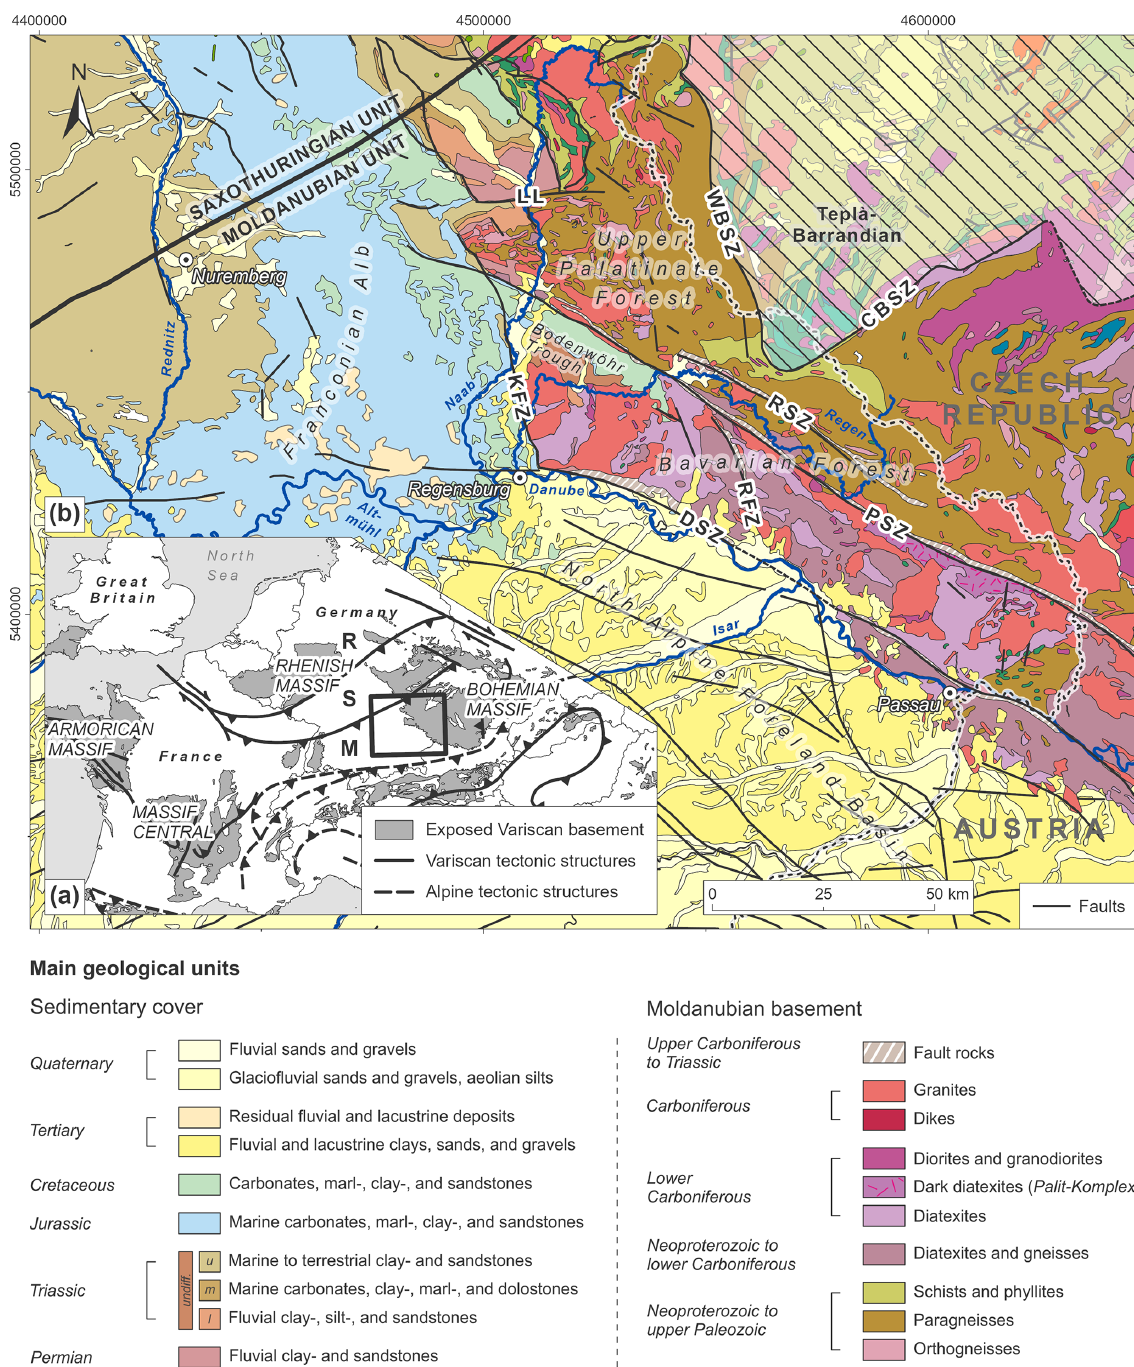
Figure 1. (a) Main areas exposing Variscan basement rocks in central Europe, including traces of major Variscan and Alpine tectonic structures (compiled from Matte, 1986; Franke, 1989; Neubauer and Handler, 2000; Barrier et al., 2004; Asch, 2005). (b) Geological and tectonic framework of the southwestern Bohemian Massif (compiled from Freudenberger and Schwerd, 1996; Toloczyki et al., 2006; Teipel et al., 2008; Galadí-Enríquez et al., 2009b). Variscan zones: R – Rhenohercynian Zone; S – Saxothuringian Zone; M – Moldanubian Zone. Fault zones: CBSZ – Central Bohemia Shear Zone; DSZ – Danube Shear Zone; KFZ – Keilberg Fault Zone; LL – Luhe Line; PSZ – Pfahl Shear Zone; RSZ – Runding Shear Zone; RFZ – Rattenberg Fault Zone; WBSZ – West Bohemia Shear Zone.